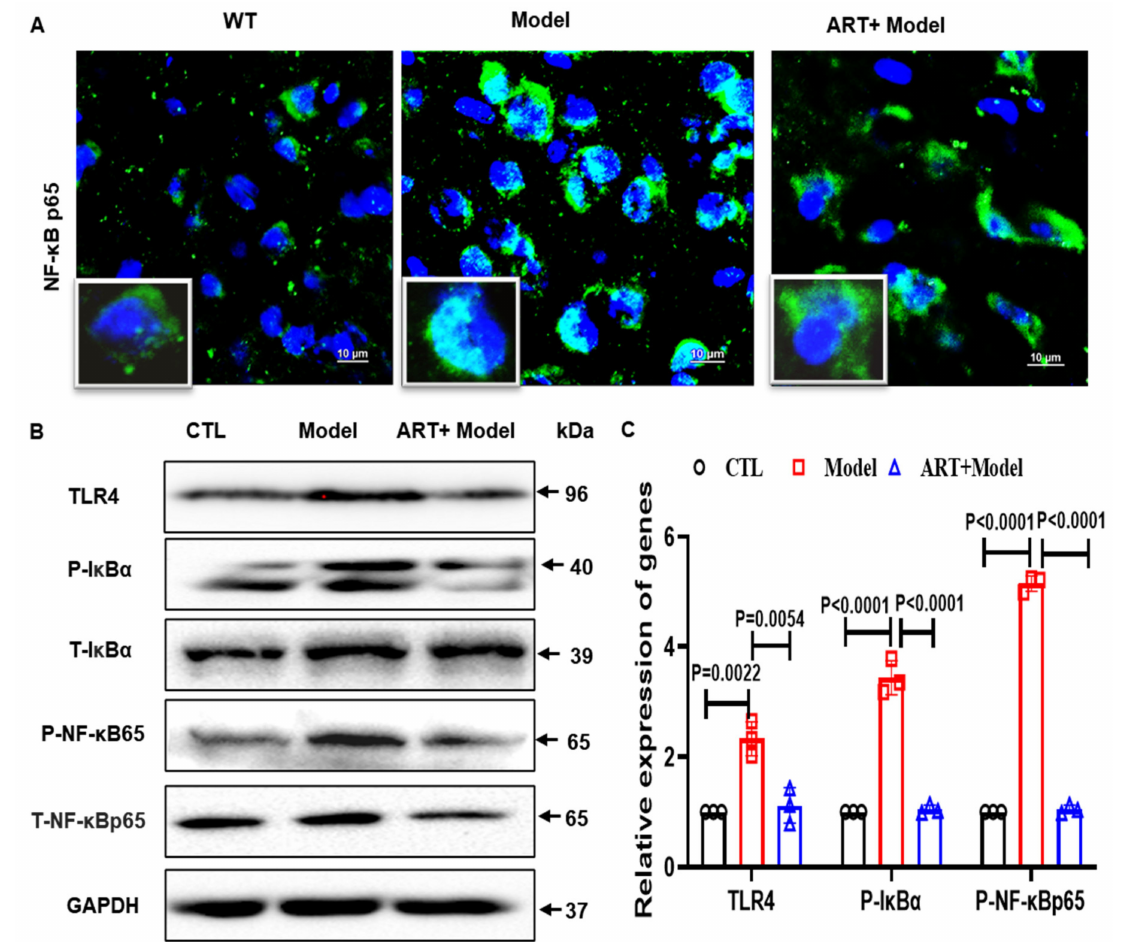
Figure 9. Artemisinin inhibits TLR4/NF κ B signaling pathway. ( A ) IF of NF- κ B65 in the C57 model. ( B ) Western blot of TLR4, p-NF- κ B and p-I κ B α in the C57 model. ( C ) Quantitation the expression level of TLR4, p-NF- κ B and p-I κ B α in ( A ). p < 0.05 was considered significantly